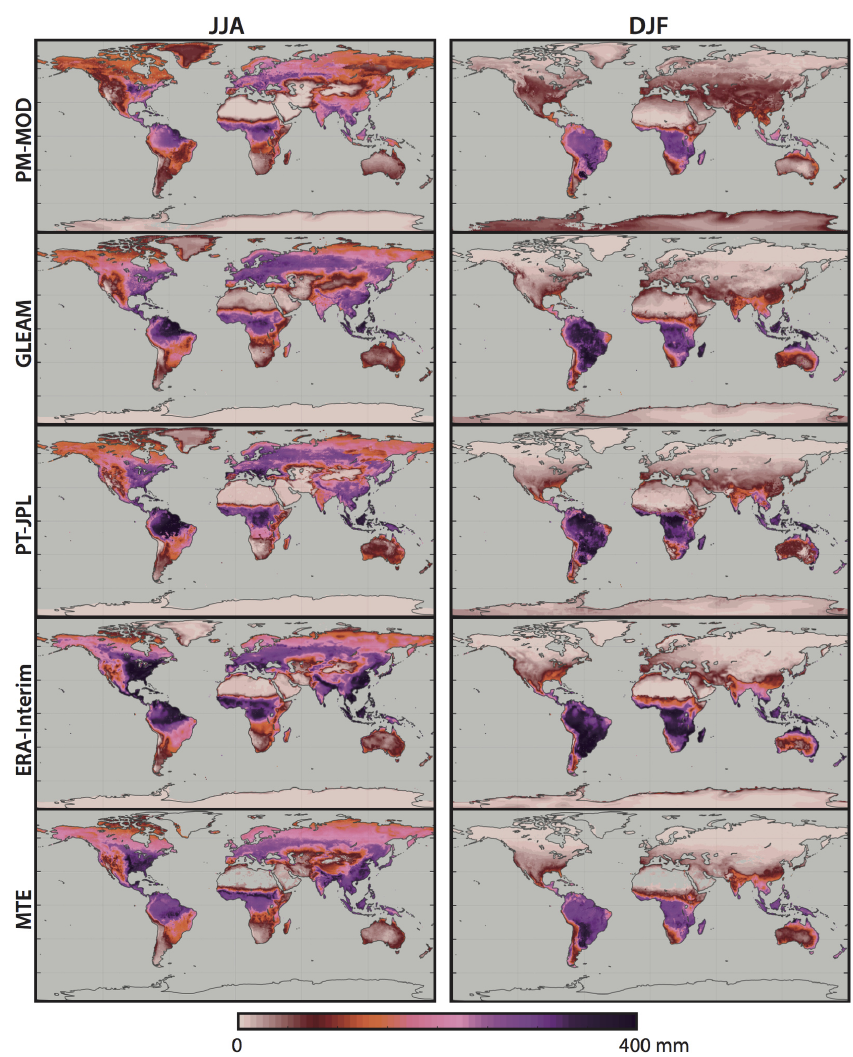
Figure 7. Mean seasonal differences. Average evaporation for PM-MOD, GLEAM, and PT-JPL during boreal summer (June, July, and August) and austral summer (December, January, and February). ERA-Interim reanalysis and MTE are considered for comparison. The 3 years of data (2005–2007) are used in the calculation of these seasonal